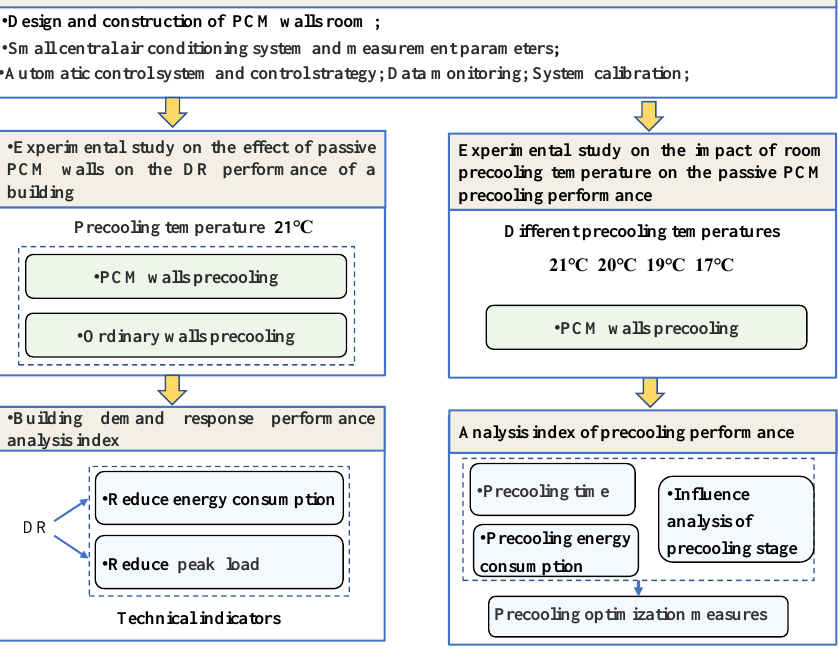
Figure 5. Experimental schemes.